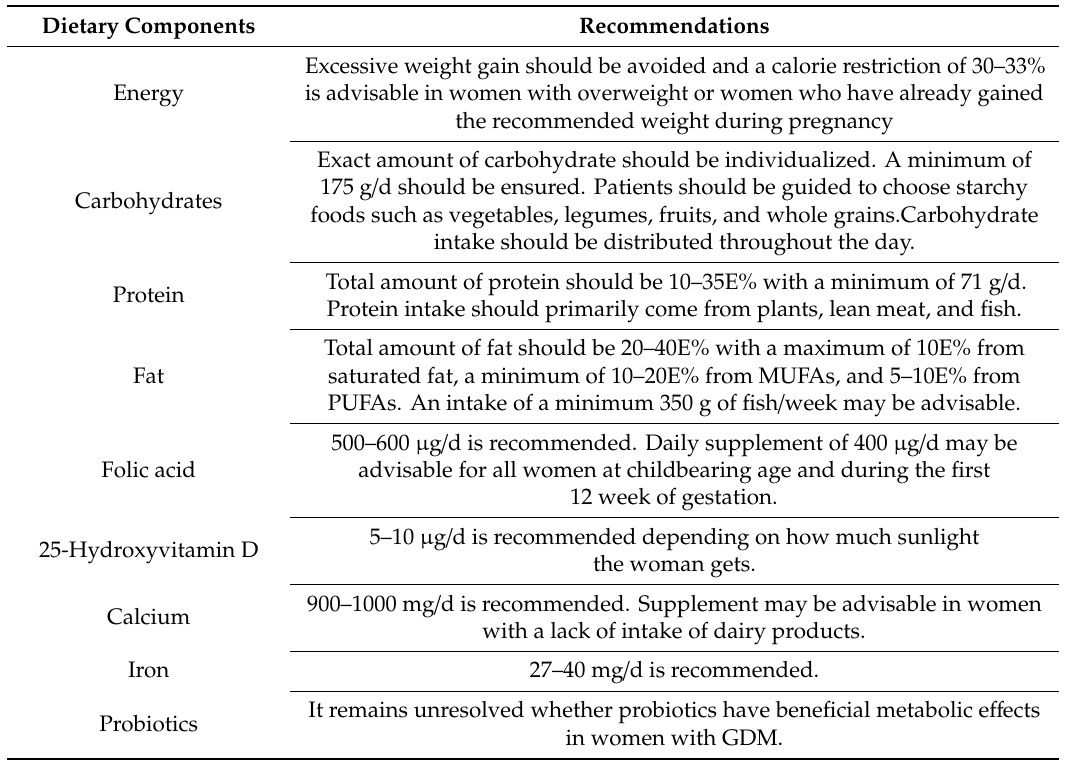
Table 6. Summary of